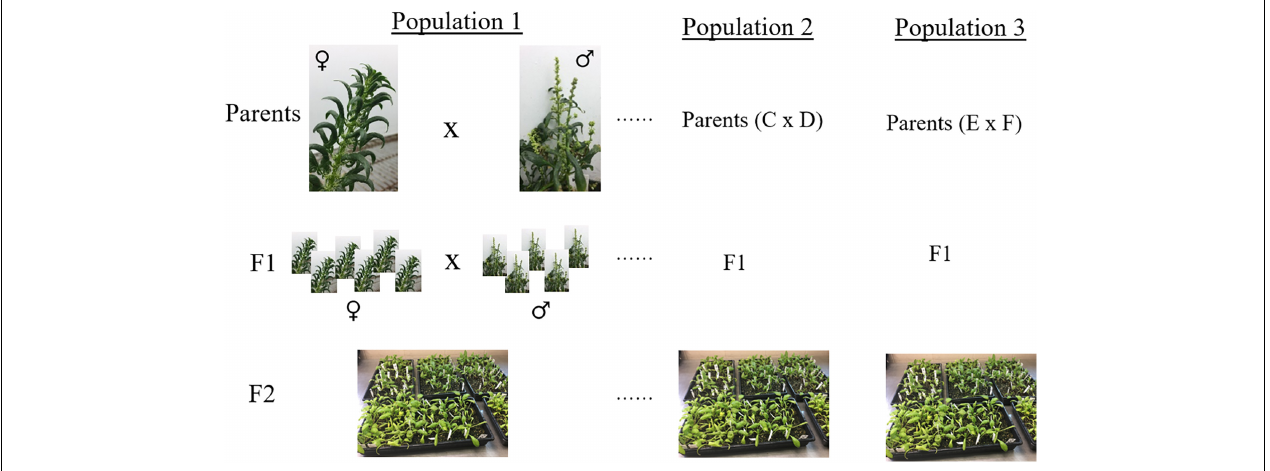
FIGURE 1 | Schematic representation of the breeding population generated in this study. Spinach inbred lines resistant to race 13 of P. effusa were crossed with a susceptible inbred to produce F1 seeds. The heterozygous resistant F1 cultivar was grown with susceptible F1 cultivar, allowed to inter-cross in a crossing block, and F2 seeds were generated. Multiple segregating populations were phenotyped and genotyped that constitute the association panel in this study.